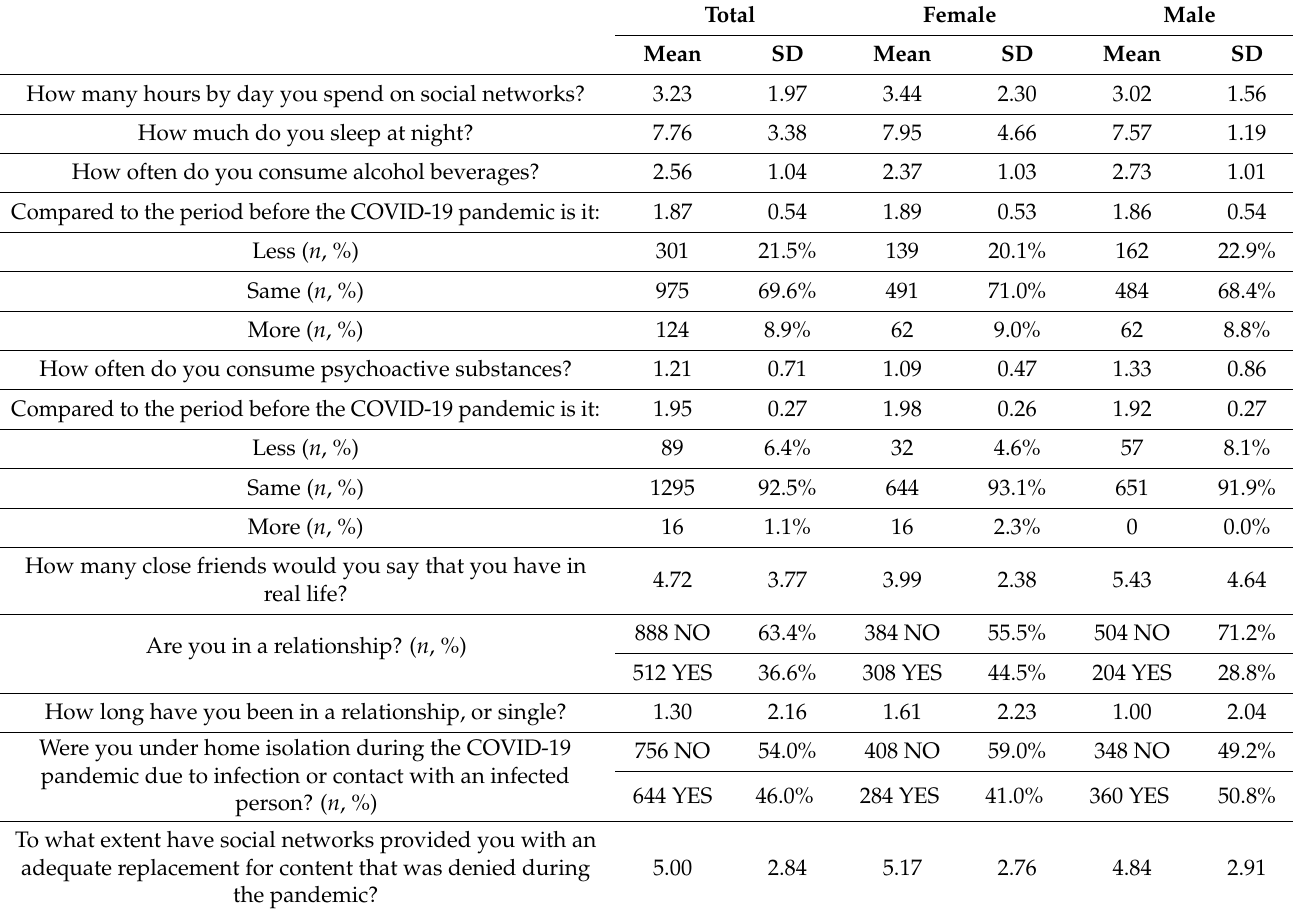
Table 1. Lifestyle habits of the surveyed students corresponding to COVID-19 pandemic.